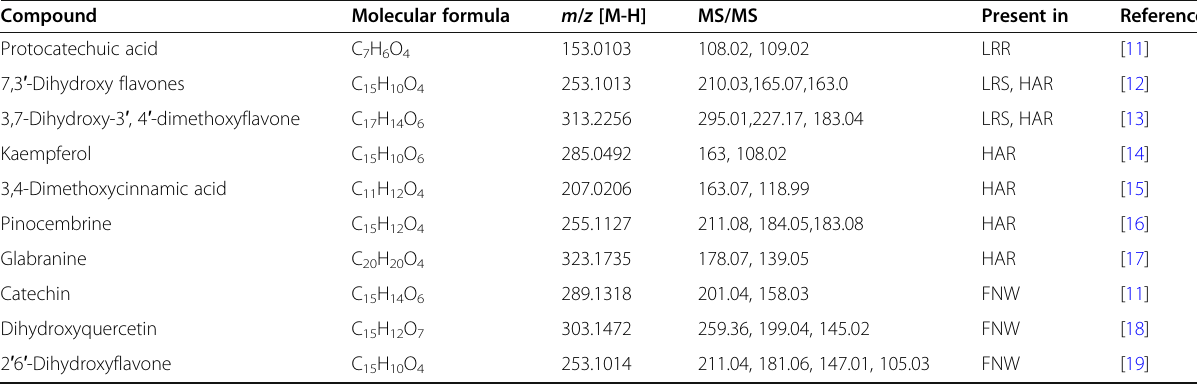
Table 4 LC-MS/MS analysis of the phenolic fraction of selected Jivanti species